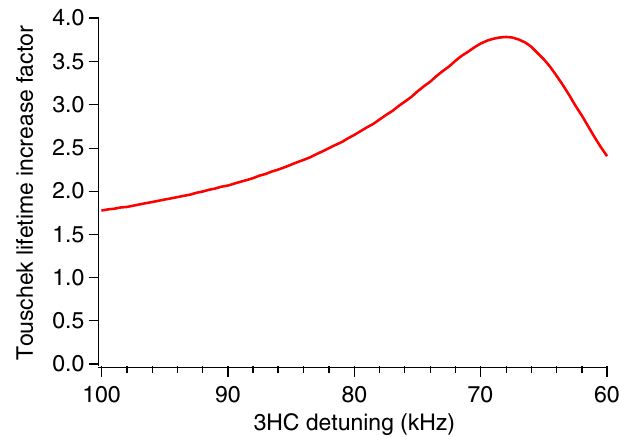
FIG. 18. (Color) Touschek lifetime increase factor in function of the 3HC detuning, calculated for a beam current of 315 mA.